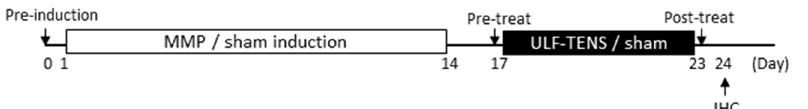
Figure 6. Experimental design. Electrophysiological measurements of endplate noise (EPN), and maximum jaw-opening distance were evaluated. Measurements were obtained before induction (day 0, pre-induction), three days after 14-day MMP induction (before ULF-TENS treatment, day 17, pre-treatment), and after 7-day ULF-TENS treatment (day 23, post-treatment). All animals were then sacrificed on day 24 for substance P, MOR, and c-Fos immunohistochemistry